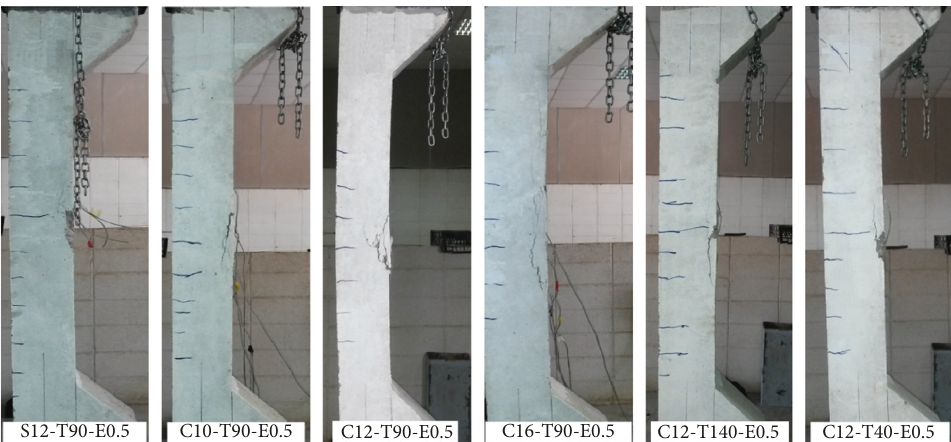
Figure 5: Crack pattern and mode of failure of column specimens with e � 0.5 h .